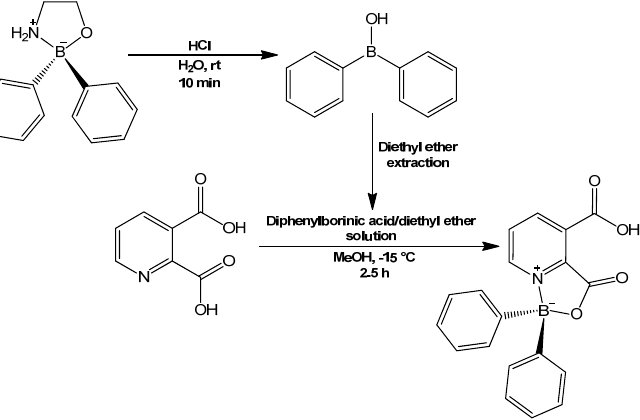
Figure 5 . Synthesis of BZQuin . The hydrolysis of 2 ‐ APB was carried out previously and inde ‐ Figure 5. Synthesis of BZQuin . The hydrolysis of 2-APB was carried out previously and independently pendently from the synthesis of the diphenylboroxazolidone. from the synthesis of the diphenylboroxazolidone.